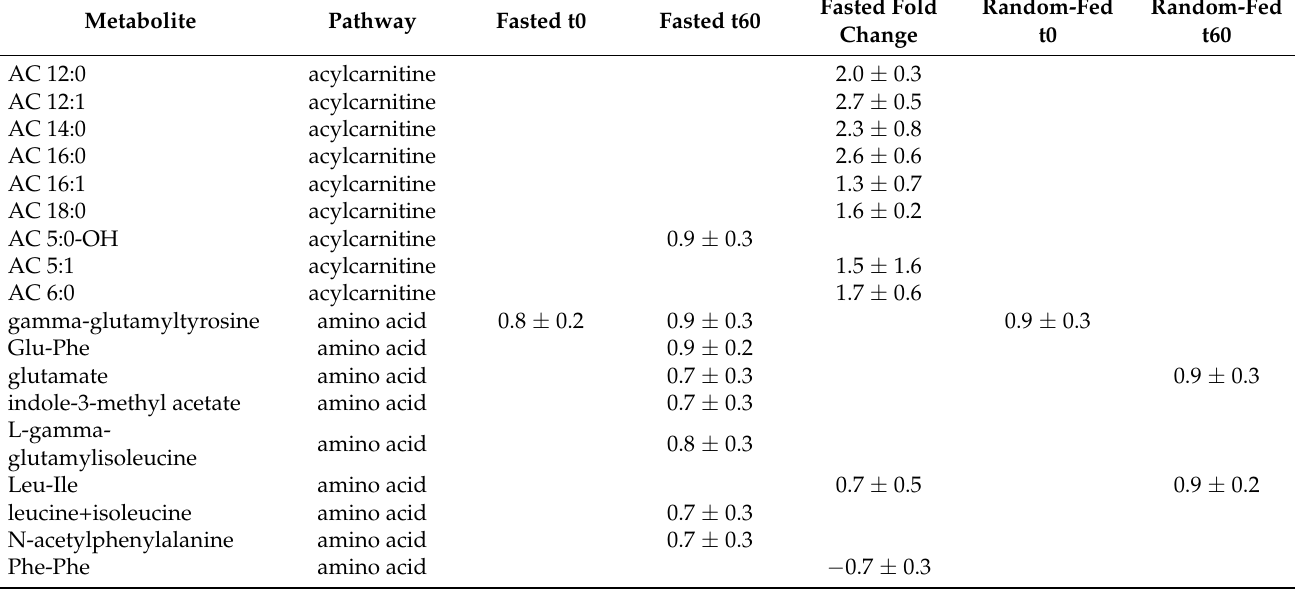
Table 2. Metabolites associated with HOMA-IR in females with overweight and obesity at the Fasted and Random-Fed Visit. Beta coefficients and standard errors from linear regression models are reported, adjusting for age at the Fasted Visit (FDR <